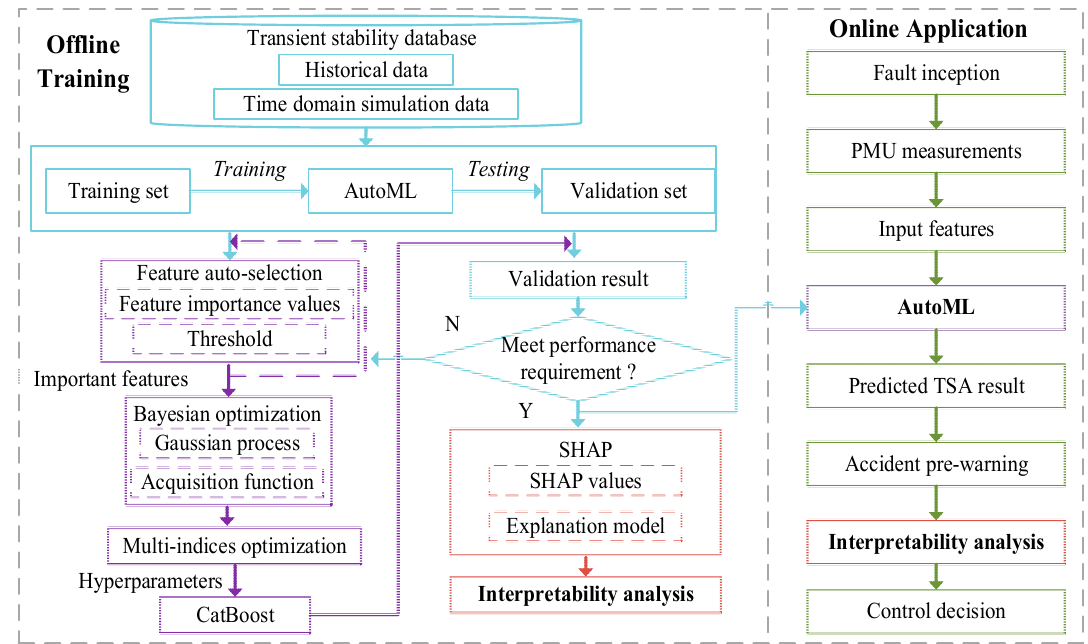
Figure 2. Flowchart of the proposed interpretable AutoML-based TSA method.